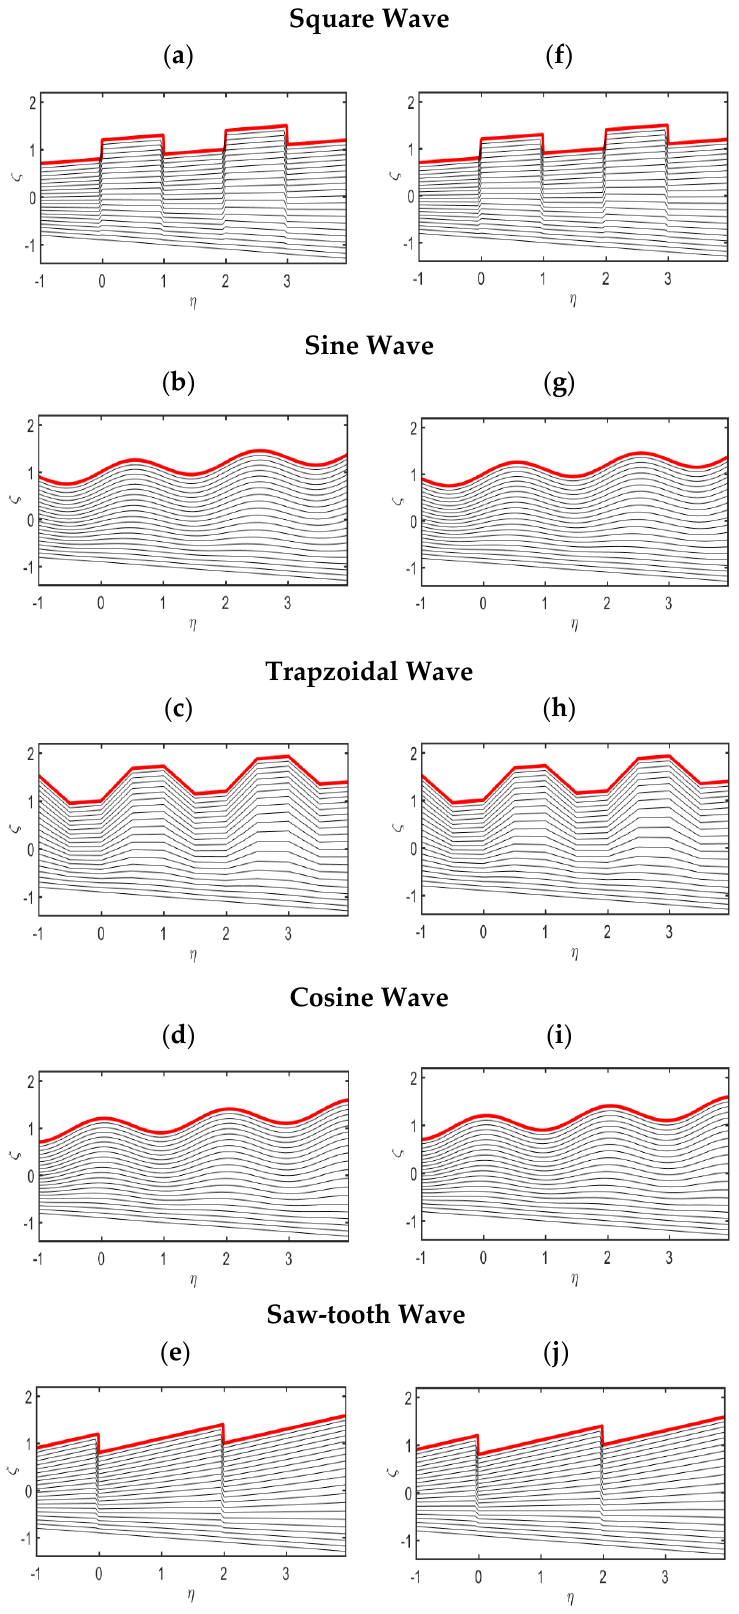
Figure 6. Trapping phenomena for curvature parameter (𝜎 = 3,∞) using ( a , f ) square wave, ( b , g ) sine wave, ( c , h ) trapezoidal wave, ( d , i ) cosine wave, ( e , j ) saw-tooth wave at 𝑞 = −2,𝐷𝐴 = 10,𝛼 = 0.1,𝛽 = 0.1,and 𝜙 = 0.2.